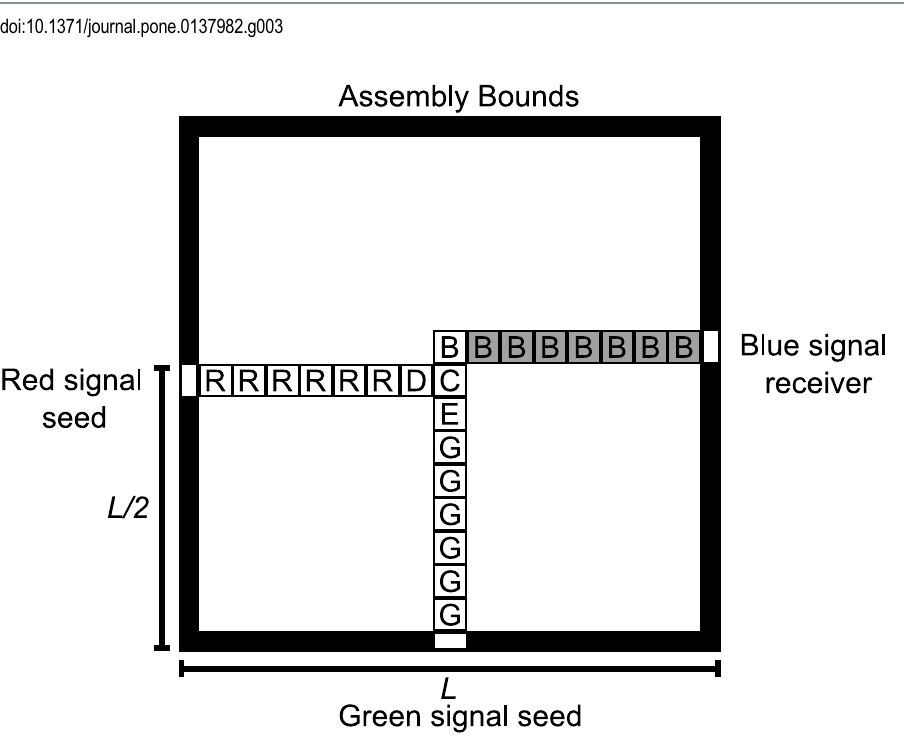
Fig 4. The ideal RGB assembler is designed to grow two signals, one red from site R and one green from site G, toward a point of cooperation C. The seed is an L × L square perimeter where inputs R and G and output B are to be placed. Cooperation is achieved at the point C, where the signals would “ meet ” to effect the AND and produce a deterministic signal that is recorded at output